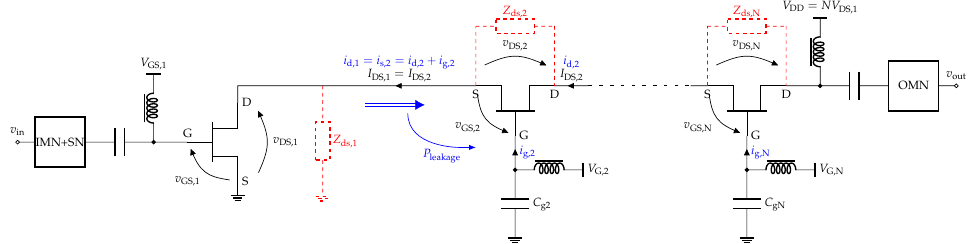
Figure 1. N -device stacked PA with highlighted device matching condition (red, dashed) and gate power leakage (blue).